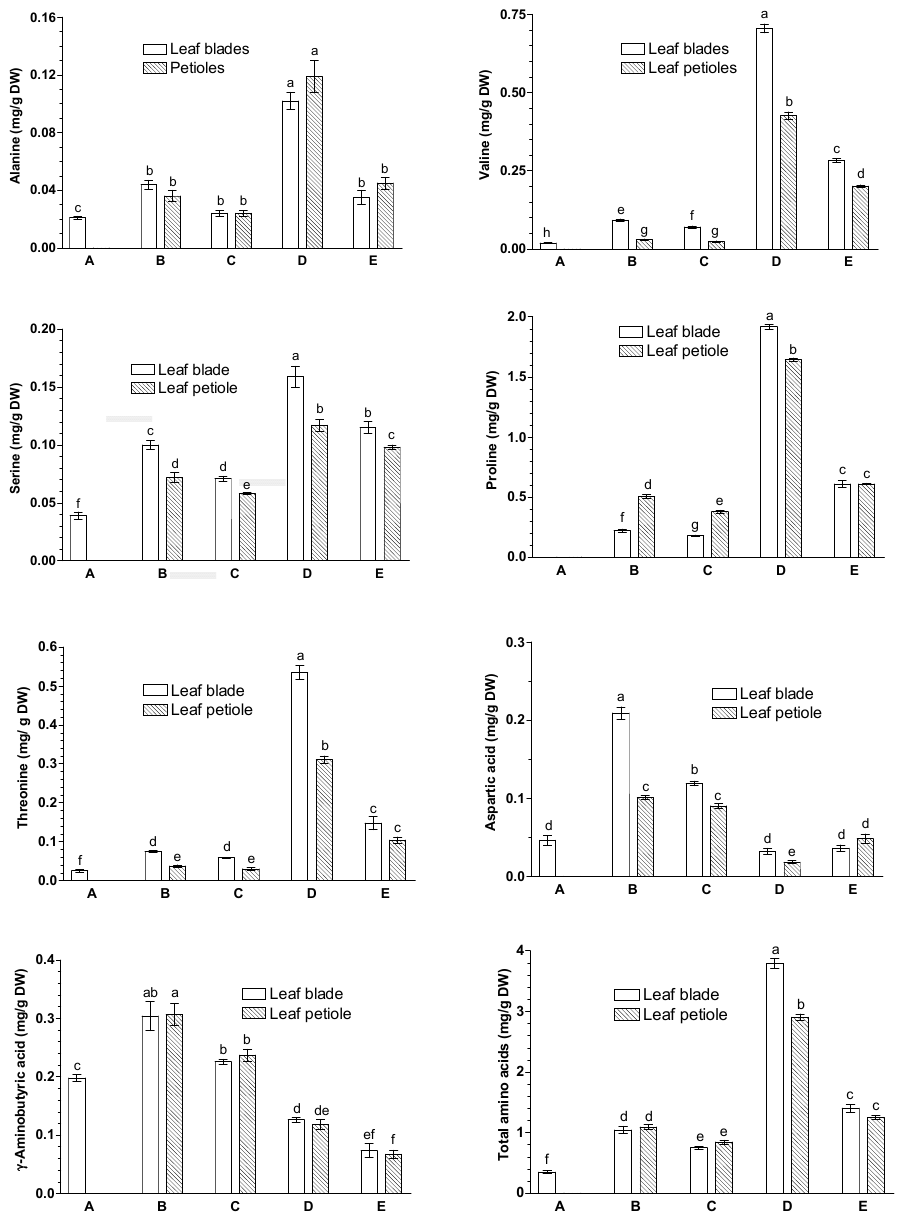
Figure 1. Effects of methyl jasmonate (JA-Me) applied to the adaxial or abaxial side of the leaf blade on the contents (mg/g DW) of free amino acids in leaf blades and petioles of G. biloba . Mean results ± SD followed by the same letter were not significantly different ( p < 0.05) according to Tukey’s test.